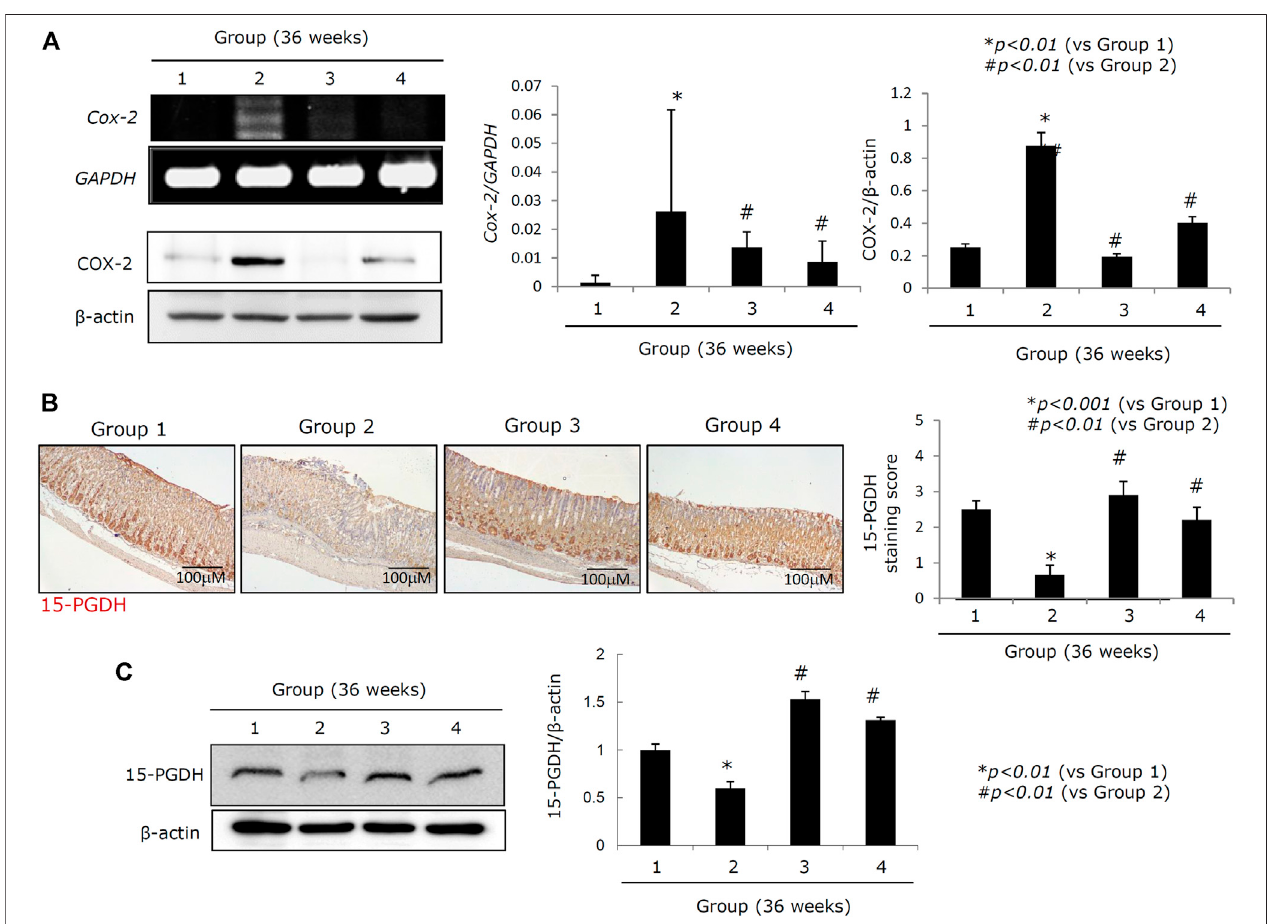
FIGURE 4 | Changes of COX-2 and 15-PGDH according to groups. (A) RT-PCR for COX-2 mRNA and western blot for COX-2. (B) Left: immunohistochemical staining for 15-PGDH, x100 magni fi cation; right: mean expressions according to groups. (C) Western blot for 15-PGDH. All data represent mean ± SD ( n (cid:1) 10).